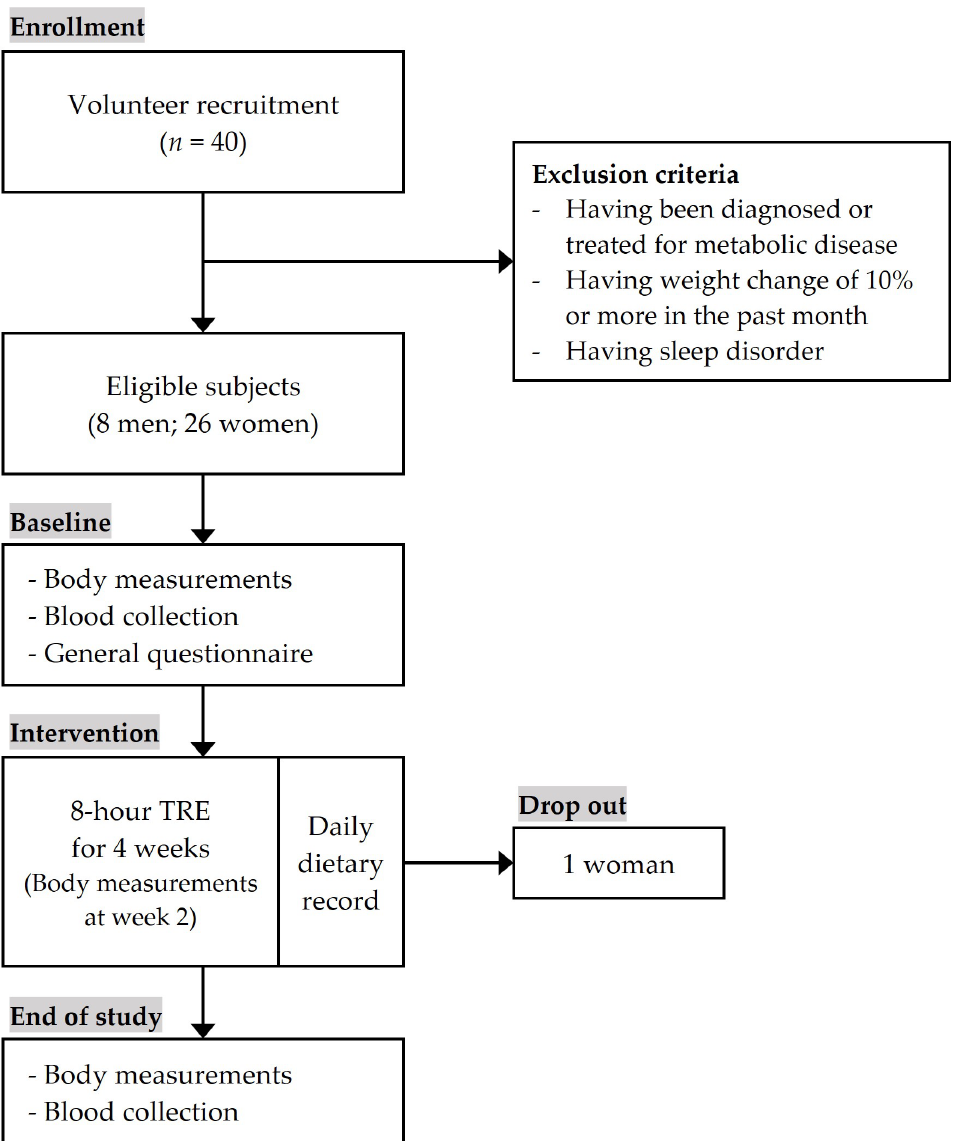
Figure 1. Study schematic